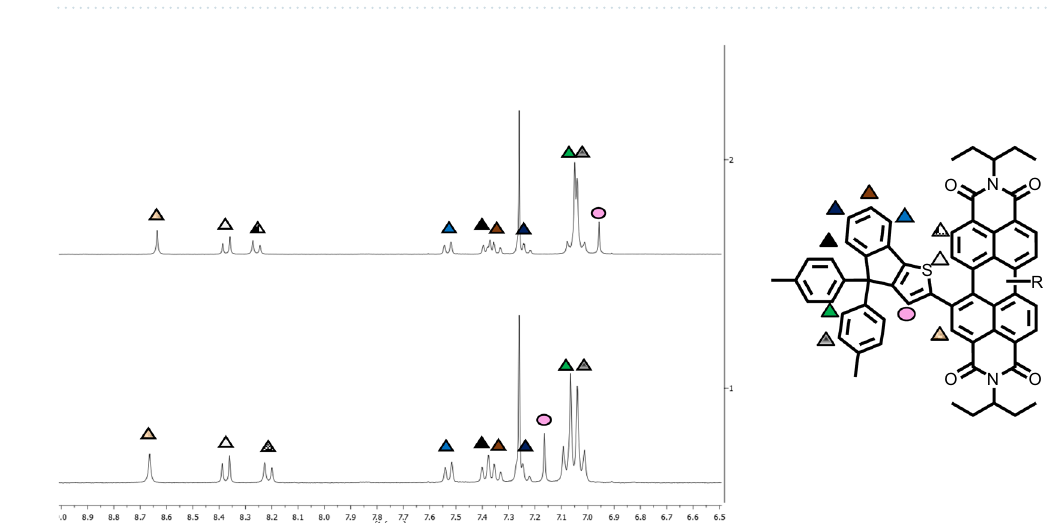
Figure 2. 1 H NMR (300 MHz) spectra of 1,6-i (top) and 1,7-i (bottom) in CDCl 3 at 25